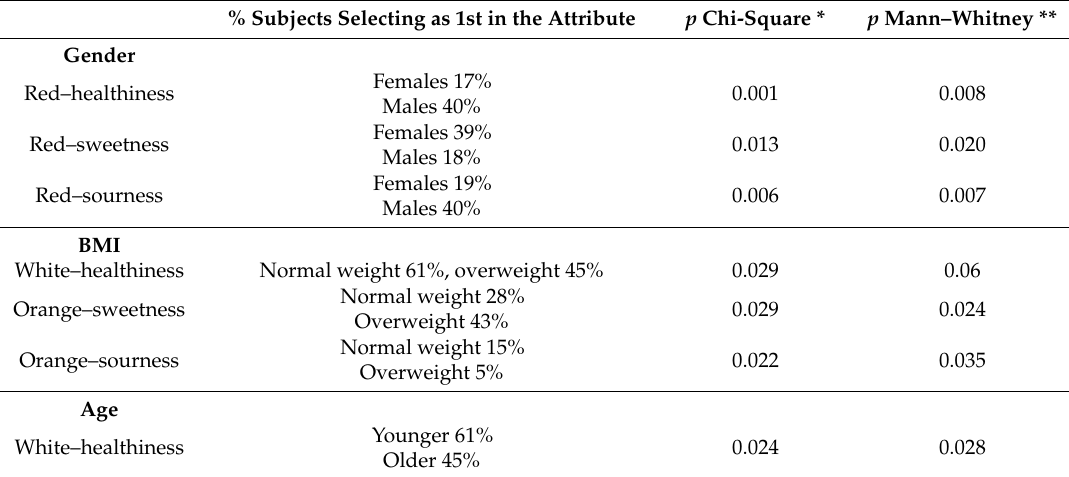
Table 3. Significant differences in color associations by background